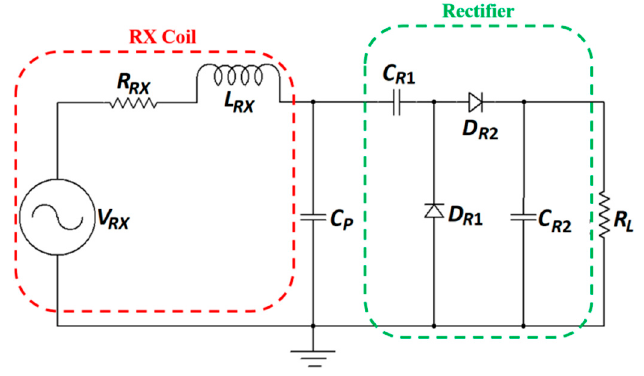
Figure 31. RX circuit for NRRMFWPT system.